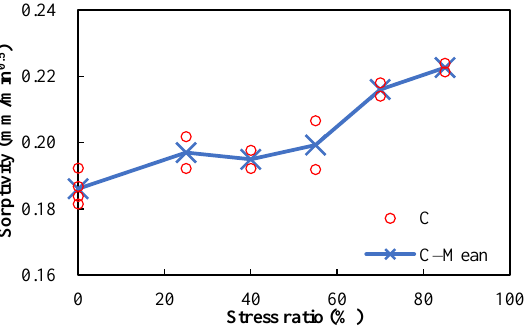
Figure 9. Sorptivities of damaged mortar specimens (w/c = 0.5) after different compressive stress levels.